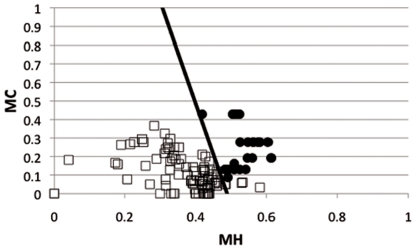
Predicting unstructured antibacterial peptides.Two physicochemical properties (Mean Charge, MC, Mean Hydrophobicity, MH) known to differentiate structured from non-structured proteins were applied to antibacterial peptides. The figure shows the paired values of a set of structured antibacterial peptides (empty squares) and unstructured antibacterial peptides (filled circles). See supplementary Table 1 for further information about the peptide sequences used for this study.